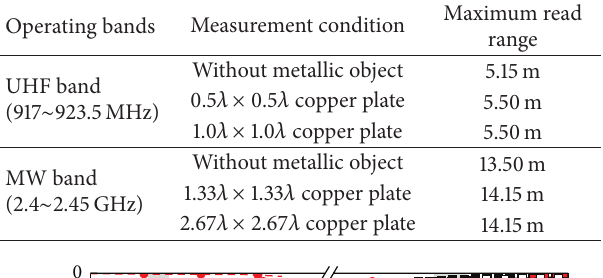
Table 1: Measured maximum read range with and without metallic objects.